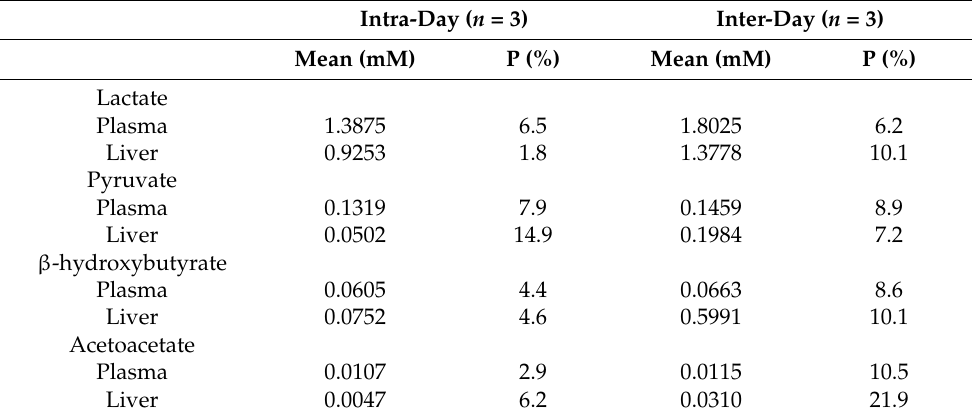
Table 5. Intra-day and inter-day precision expressed as relative standard deviation of plasma and liver samples. P: precision.